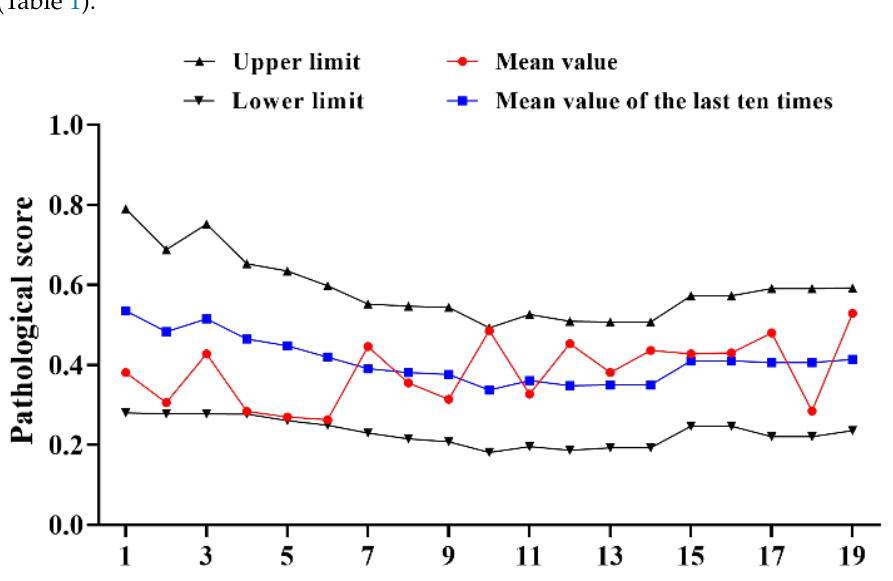
Figure 1. Statistical of pathological score of type I reference product in 2016–2022. N = 19